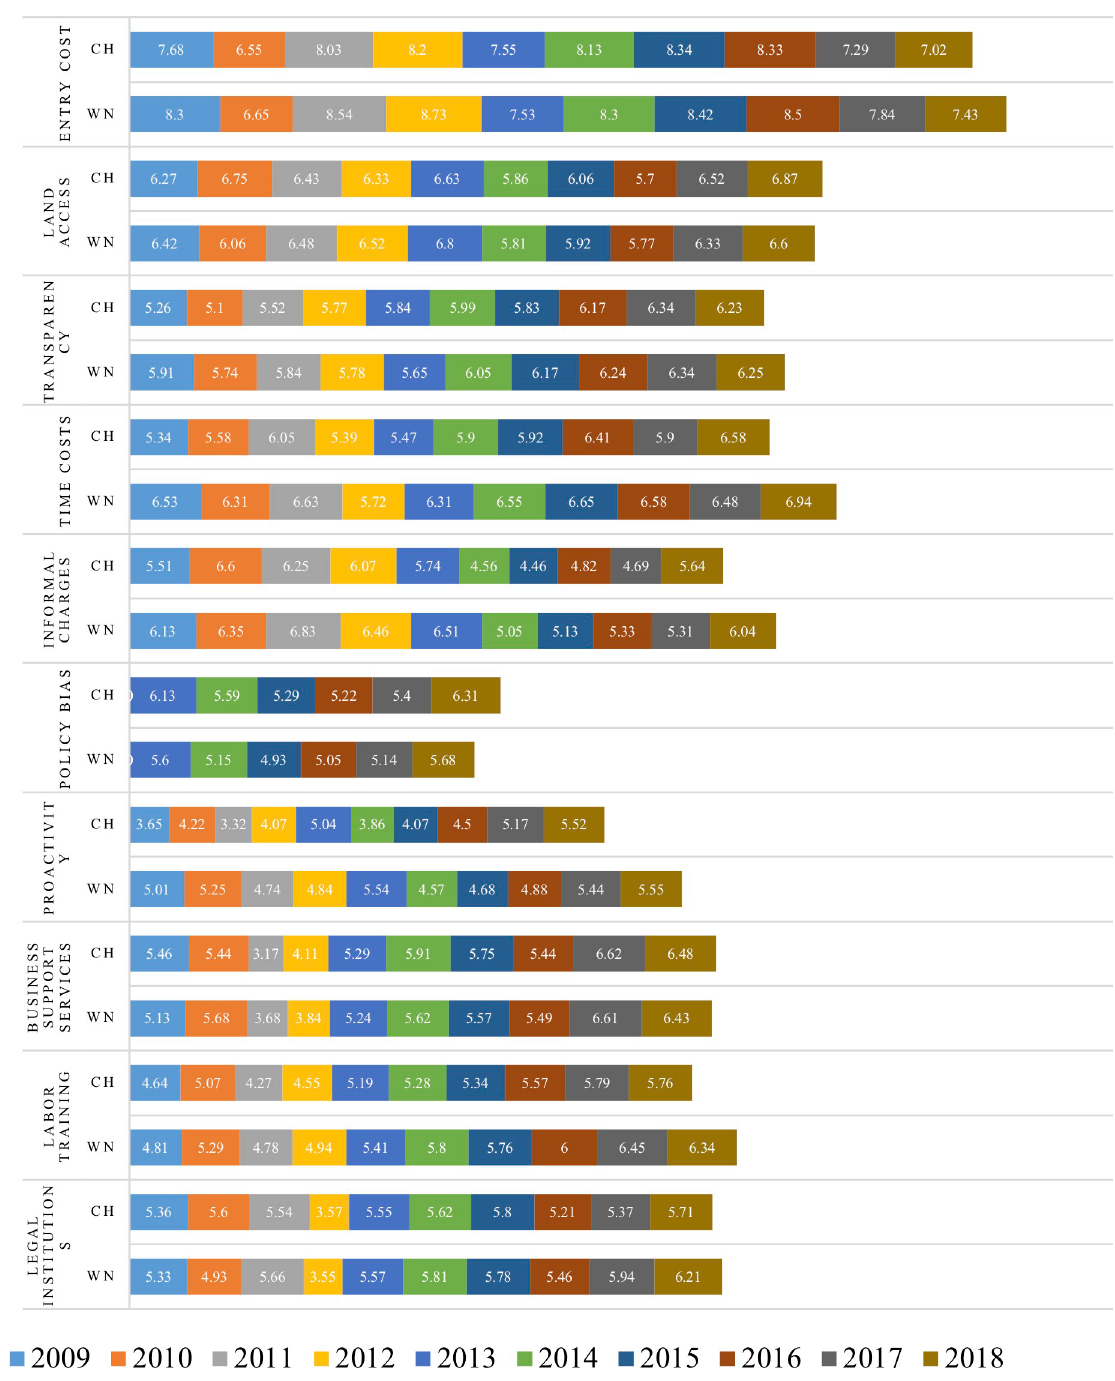
Fig 2. Median of sub-indices points of the Central Highlands and whole country in 2009–2018 period. Note : CH : Central Highland , WN : Whole nation . Unit : points Source : Author’s compilation from PCI database